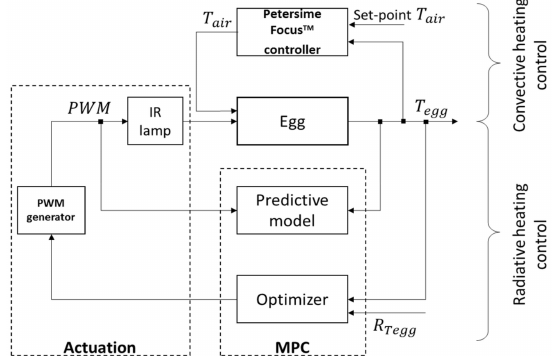
Figure 6. Block diagram representing the control strategy to combine both convective and radiative heating to control the eggshell temperature using model-predictive-controller (MPC) to regulate the eggshell temperature of incubated